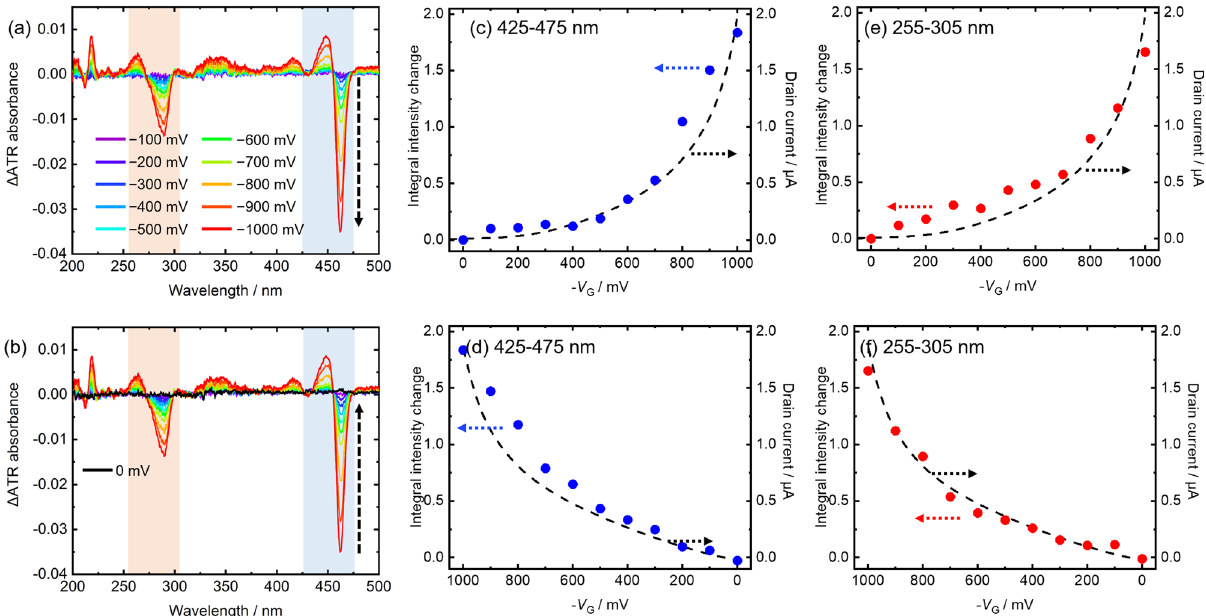
Fig. 4 Relationship between spectral behavior and device performance. a , b Difference spectra of a C 9 -DNBDT-NW fi lm and c – f their integral intensity changes as a function of the applied voltage in the c , d 425 – 475 nm and e , f 255 – 305 nm regions under gate voltage application ( a , c , e ) from 0 to − 1000 mV, and ( b , d , f ) from − 1000 to 0 mV. Arrows in c – f show the axis to